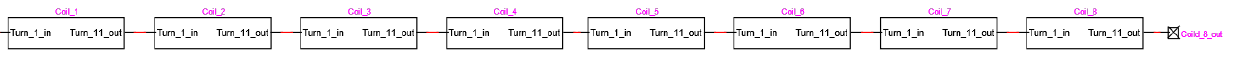
Figure 15. Ladder circuits with six layers are implemented in the MCTL model of stator windings. Table 6. Elements of ladder circuits with six layers (R (Ω), L (H)) to represent the frequency-depend- ent self-resistances and -inductances of different turns in the MCTL model.